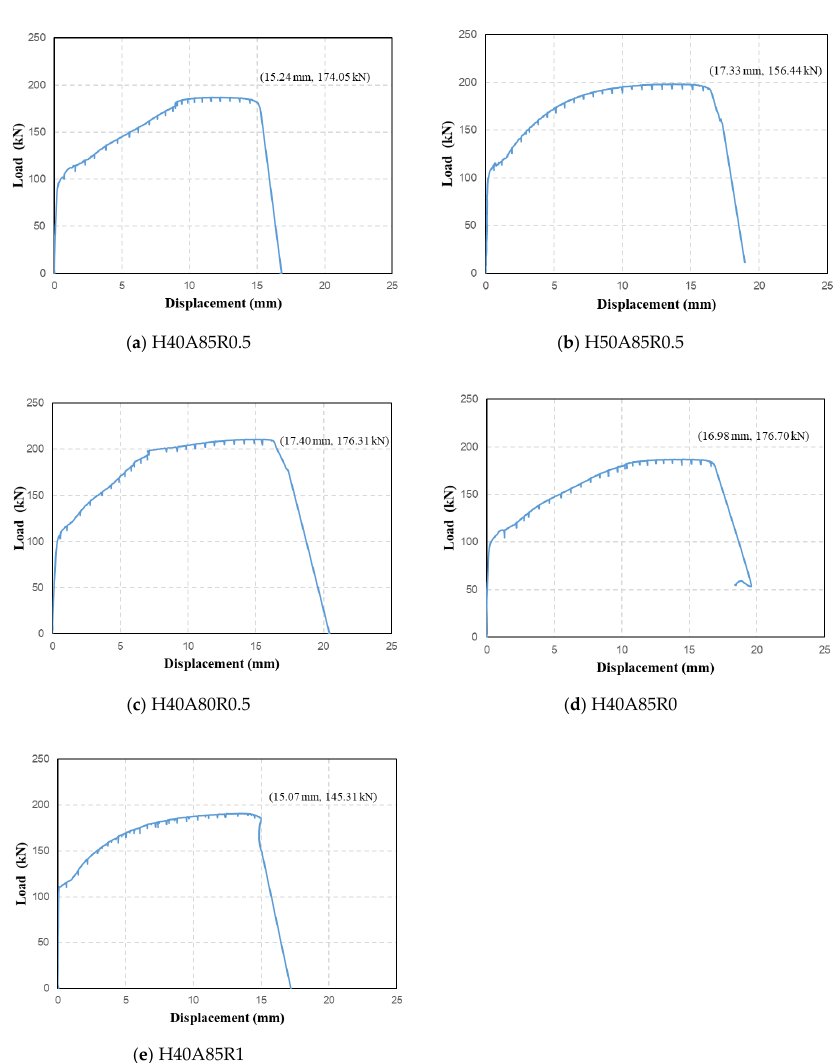
Figure 5. Load–displacement curves of tested specimens for experiments with (a) H40A85R0.5,(b) H50A85R0.5, ( c ) H40A80R0.5, ( d ) H40A85R0 and ( e ) H40A85R1